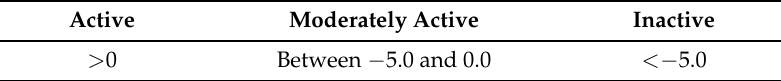
Table 5. Factors for Evaluation of the Empirical Bioactivity Scores.